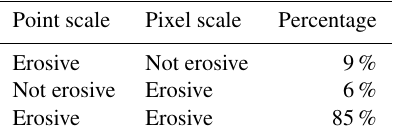
Table 3. Percentage of cases that were erosive at point (rain gauge) or pixel scale, using the pseudo-radar data; in total 579 point–pixel pairs of rain events were erosive on at least one of both scales.